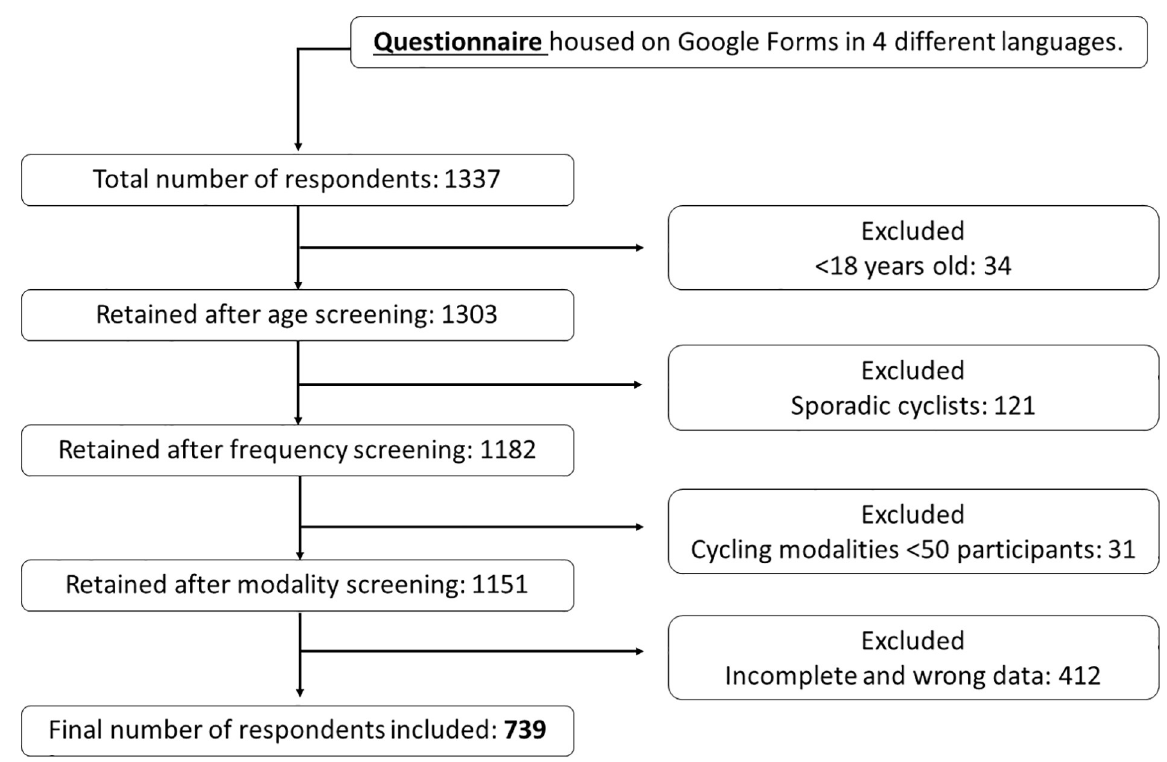
Fig 1. Acquisition of final sample size used for analyses. Sporadic participants were considered those respondents reporting < 2 ride/week, < 50 km/week, and/or < 3 hour of